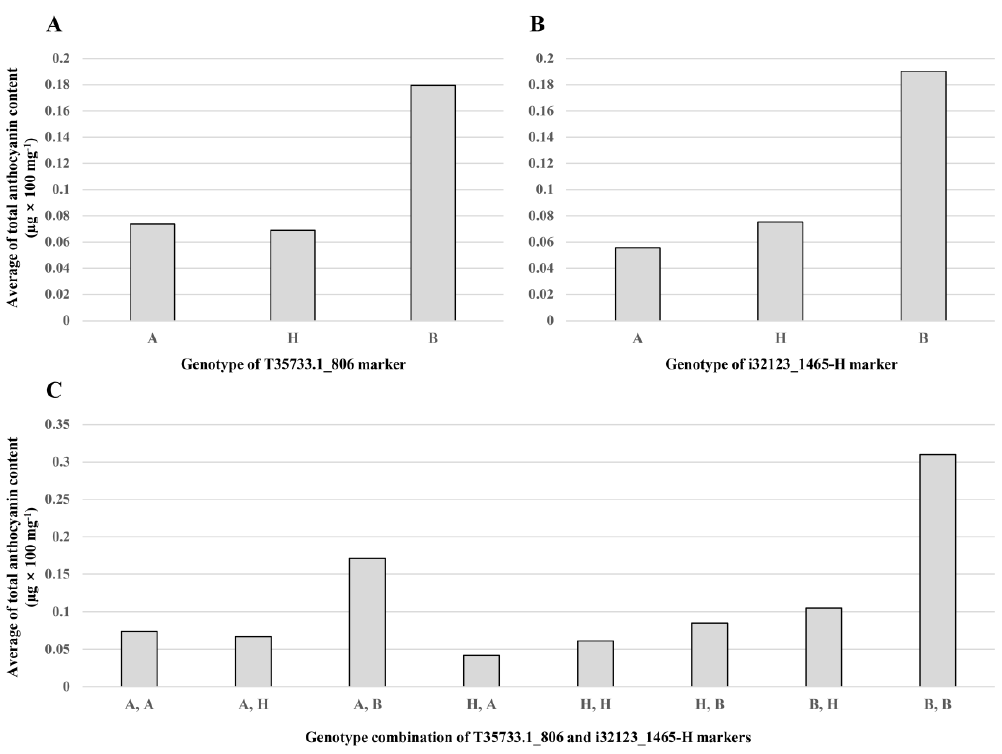
Figure 5. Comparison of the average total anthocyanin content according to genotypes for T35733.1_806 ( A ) and i32123_1465-H ( B ) markers and their combinational genotype ( C ). A, genotype of female parent (SP3B); B, genotype of male parent (H6); H, genotype of heterozygote.